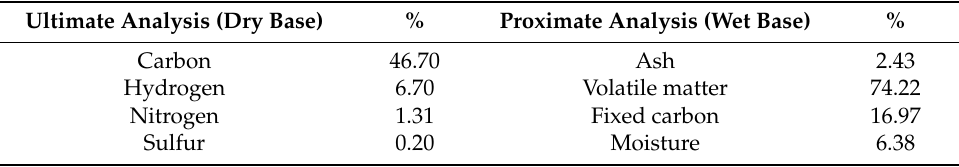
Table 1. Ultimate and proximate analyses of the